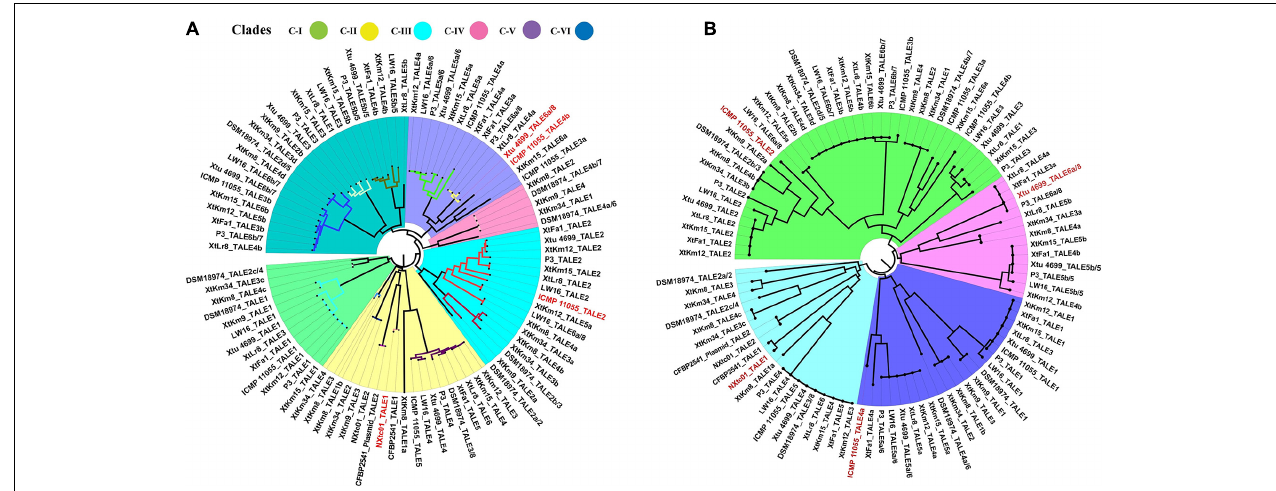
FIGURE 7 | Phylogenetic tree based on TALEs-CRR (A) and RVDs (B) in the seven Xanthomonas translucens strains sequenced in this study as well as the seven reference sequences obtained from the NCBI GenBank. TALEs were designated numerically according to the locus order ( Figure 6A ). Former TALE names are pointed out in the tree with slash, while red font indicates virulence associated TALEs. (A) DisTAL was used to construct a Neighbor-joining tree for a set of 93 TALE sequences from 14 X. translucens strains. TALEs were classified into six major clades as block shaded in different colors. TALE classes ( Supplementary Table 1 ) are represented with colored nodes with the exception of class 16 distributed among all clades. (B) FuncTAL was used to build a Neighbor-joining tree for a set of 93 TALE sequences based on TALE-RVDs. TALEs were classified into four major groups (16 classes; Supplementary Table 1 ) as block shaded in different colors.